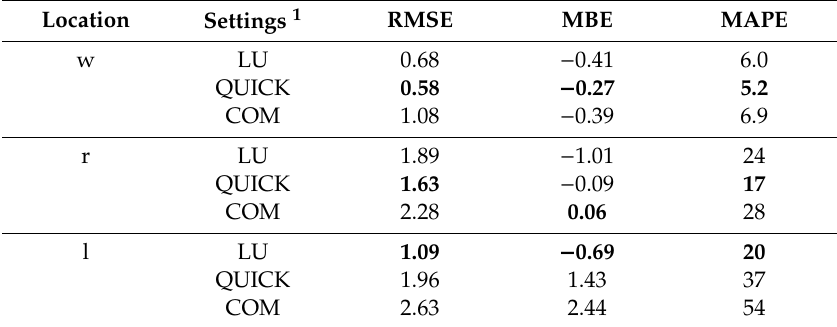
Table 6. Model root mean square error (RMSE), mean bias error (MBE), and mean absolute percent error (MAPE) for wind speeds at windward (w), ridgetop (r), and leeward (l) sensor locations at Bolund Hill. Positive MBE indicates model over-prediction. Bold font indicates the lowest error at each location. Location Settings 1 RMSE MBE MAPE w LU 0.68 − 0.41 6.0 QUICK 0.58 − 0.27 5.2 COM 1.08 − 0.39 6.9 LU 1.89 − 0.09 LU QUICK